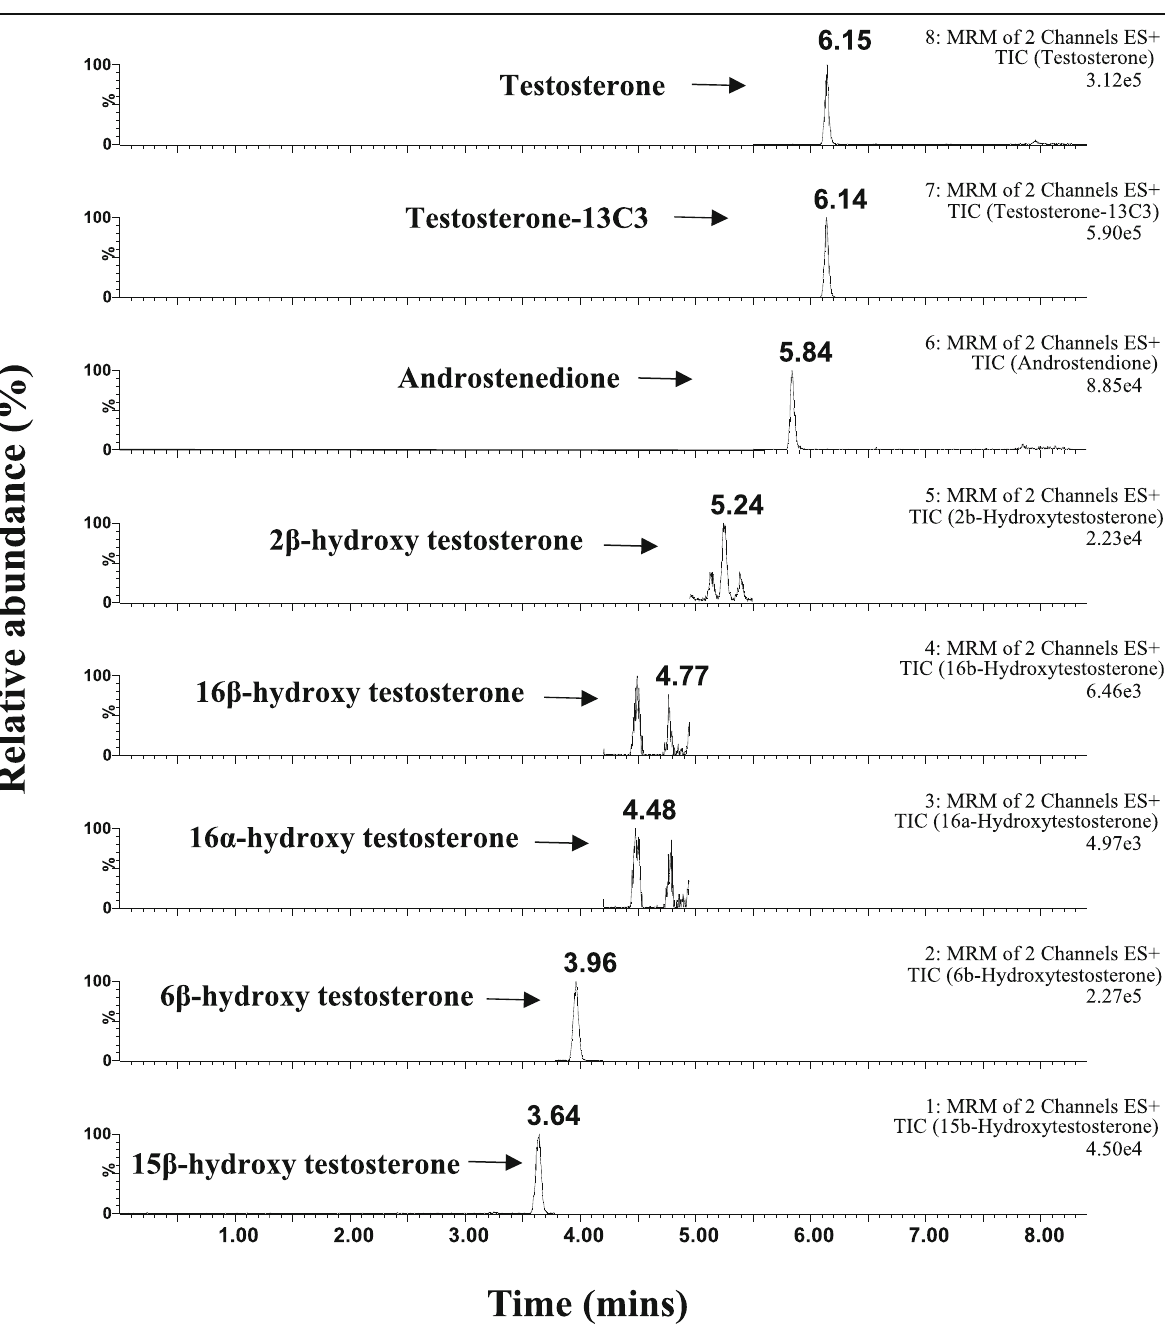
Fig. 2 The extracted ion chromatogram (XIC) for testosterone (TST), 13 C3-labeled TST, androstenedione, 2 β -hydroxy testosterone (2 β -OH TST), 16 α -hydroxytestosterone (16 α -OH TST), 16 β -hydroxytestosterone (16 β -OH TST), 6 β -hydroxytestosterone (6 β -OH TST), and 15 β -hydroxytestosterone (15 β -OH TST) produced in pooled HLM at the final concentration of 10 μ M testosterone in the presence of NADPH for 45 min at 37 °C. HLM human liver microsomes, NADPH a reduced nicotinamide adenine dinucleotide